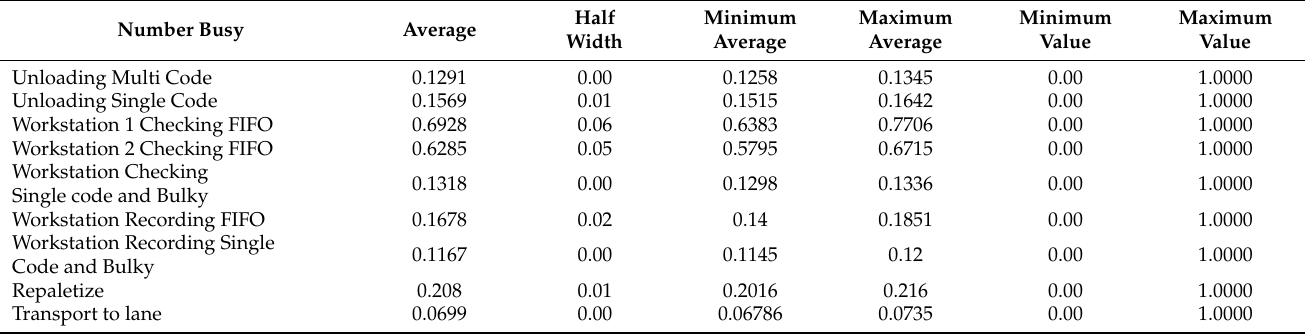
Table 7. Occupancy rate by task—Number